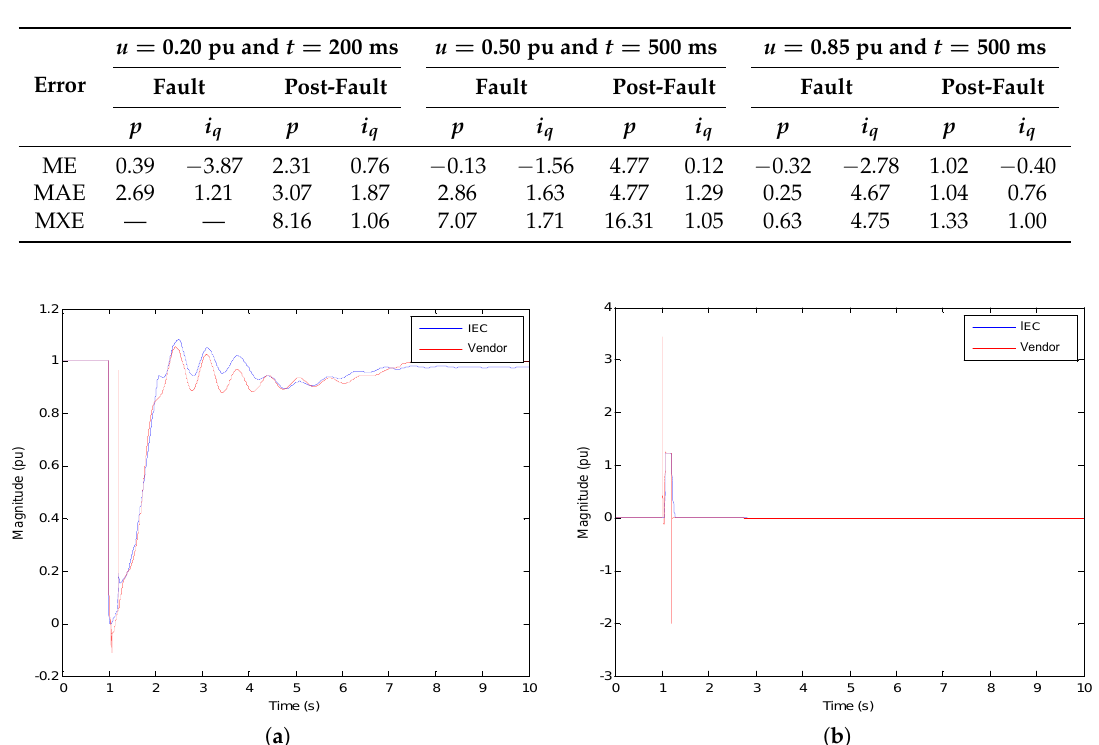
Table 2. Validation results for Type IIIB wind turbine, in %. Full load simulation scenario: p = 1.0 pu, w s = 1.1.